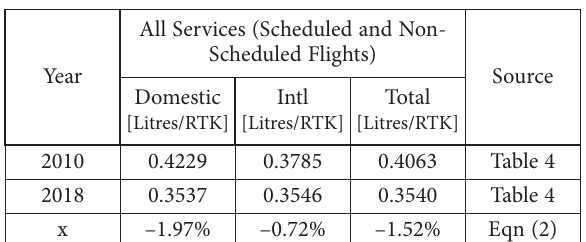
Table 5. Domestic, international, and total U.S. air carrier fleet